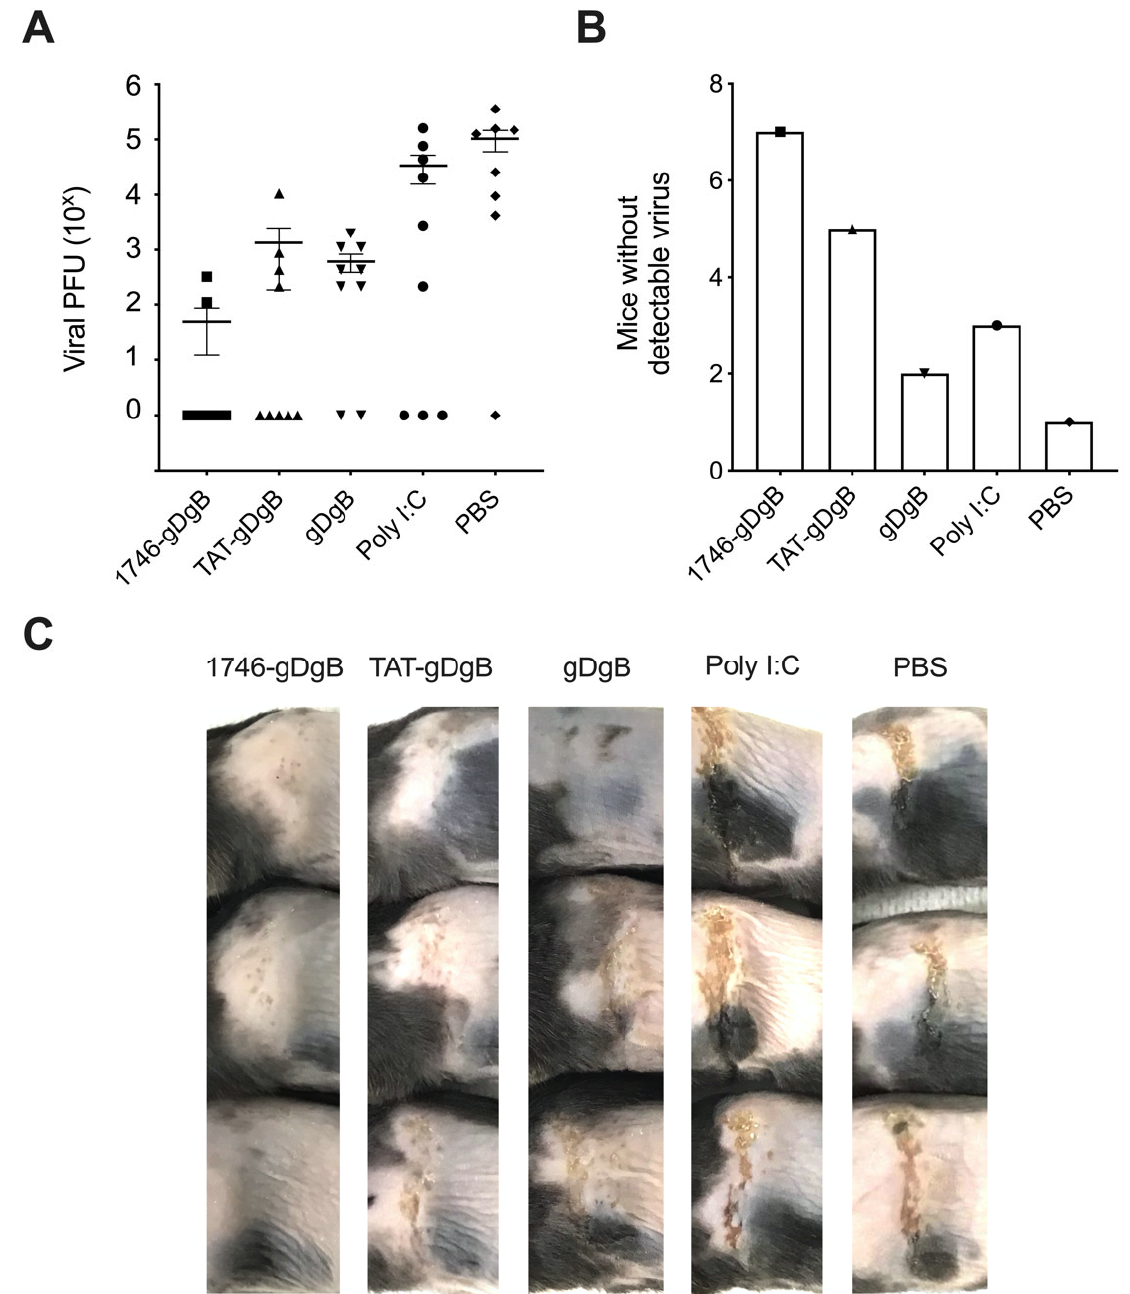
Figure 4. The 1746.gDgB vaccine generates a functional antigen-specific T cell repertoire capable of reducing HSV-1 skin infection. Treatment schedule; mice received subcutaneous vaccinations with 2 nM of vaccine constructs plus 50 ug Poly(I:C), one week prior to HSV skin infection, on the opposite flank. No prior transfer of transgenic T cells were given before infection. ( A ) Skin was taken from the infected site at the peak of viral infection (D6) and a viral plaque forming assay was performed to titrate the amount of virus present in the skin. ( B ) The number of mice from each group which had no detectable viral load in their skin sample. ( C ) Photographs depict the skin infection site of three representative mice from each treatment group. Herpes zosteriform skin lesion is clearly visible in Poly(I:C) and PBS treated animals and reduced in vaccine groups. Data are from three independent experiments and n = 9 for each group, displayed as mean +/ − SEM. Three animals from a single representative experiment were used for photographs.